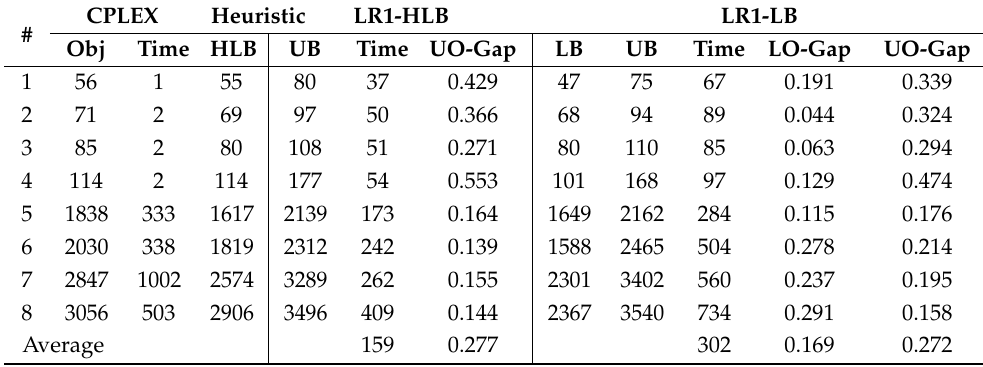
Table 7. Computational results to compare the CPLEX and LR 1 for small size instances.